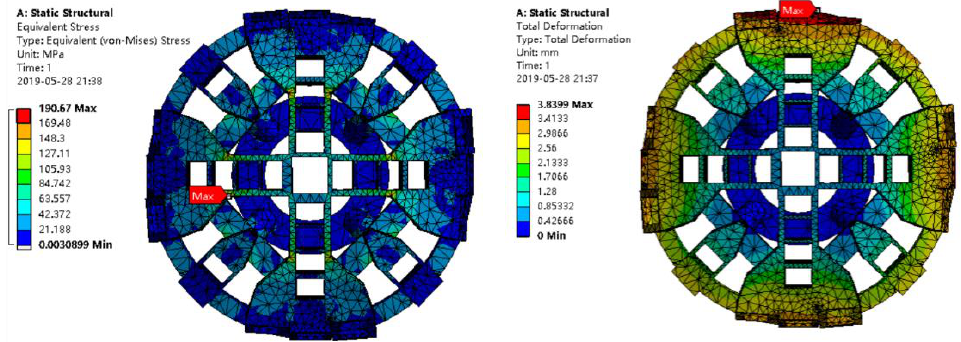
Figure 5. Static analysis results of cutterhead.